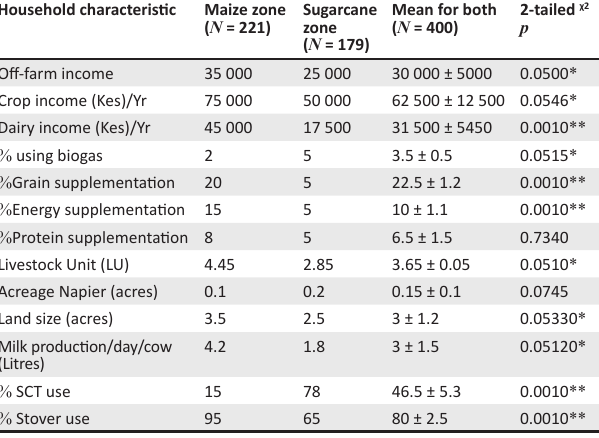
TABLE 2: Mean values of household socio-economic characteristics in Kakamega and Bungoma counties. Household characteristic Maize zone